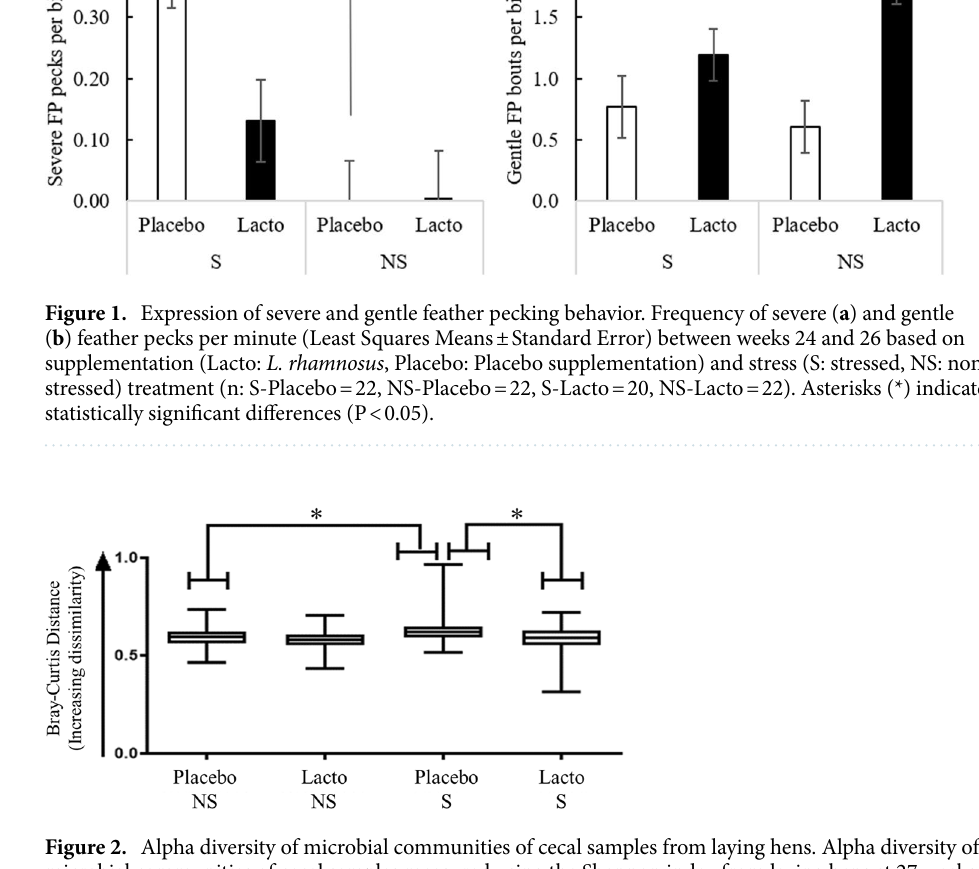
Figure 2. Alpha diversity of microbial communities of cecal samples from laying hens. Alpha diversity of microbial communities of cecal samples measured using the Shannon index from laying hens at 27 weeks of age based on supplementation (Lacto: L. rhamnosus , Placebo: Placebo supplementation) and stress (S: stressed, NS: non-stressed) treatment (n: S-Placebo = 22, NS-Placebo = 22, S-Lacto = 18, NS-Lacto =